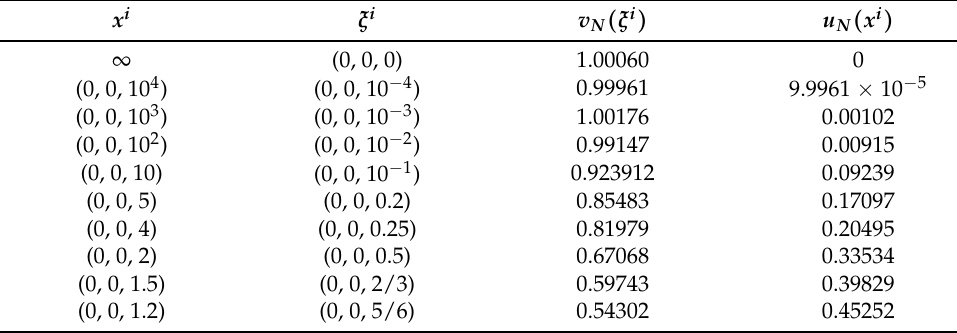
Table 5. Results for Problem 1 (in Example